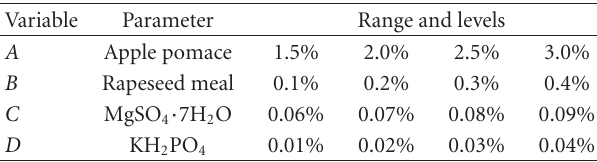
Table 3: Experimental range and levels of the independent variables of orthogonal design for the optimization of strain Hhs.015 T alternative cultural medium.